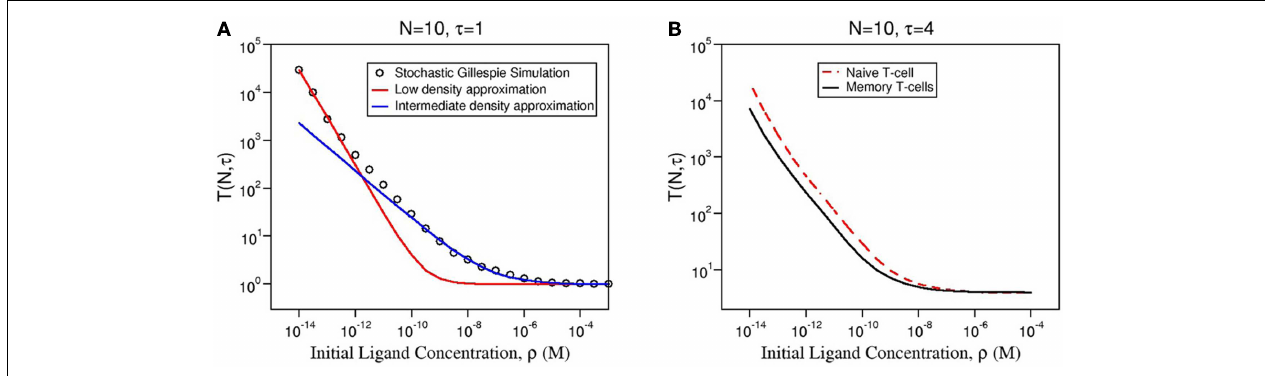
FIGURE 5 | (A) Comparison of the numerical solution of Model 2 (Gillespie algorithm with the parameters summarized in Table 2 ) and the approximate solution [equation (3)] for ligand 4P and the same parameters as in Figure 4 . (B) Comparison of the mean MTSI for naive (red dashed line) and memory (solid black line) T